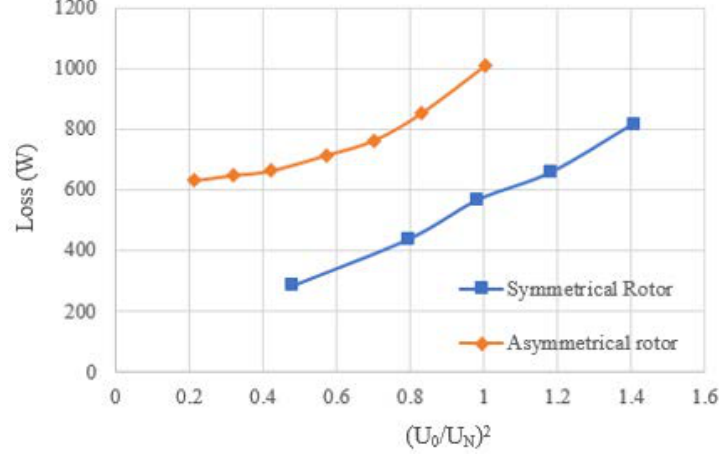
Figure 12. Power losses of the constant speed-variable excitation test.